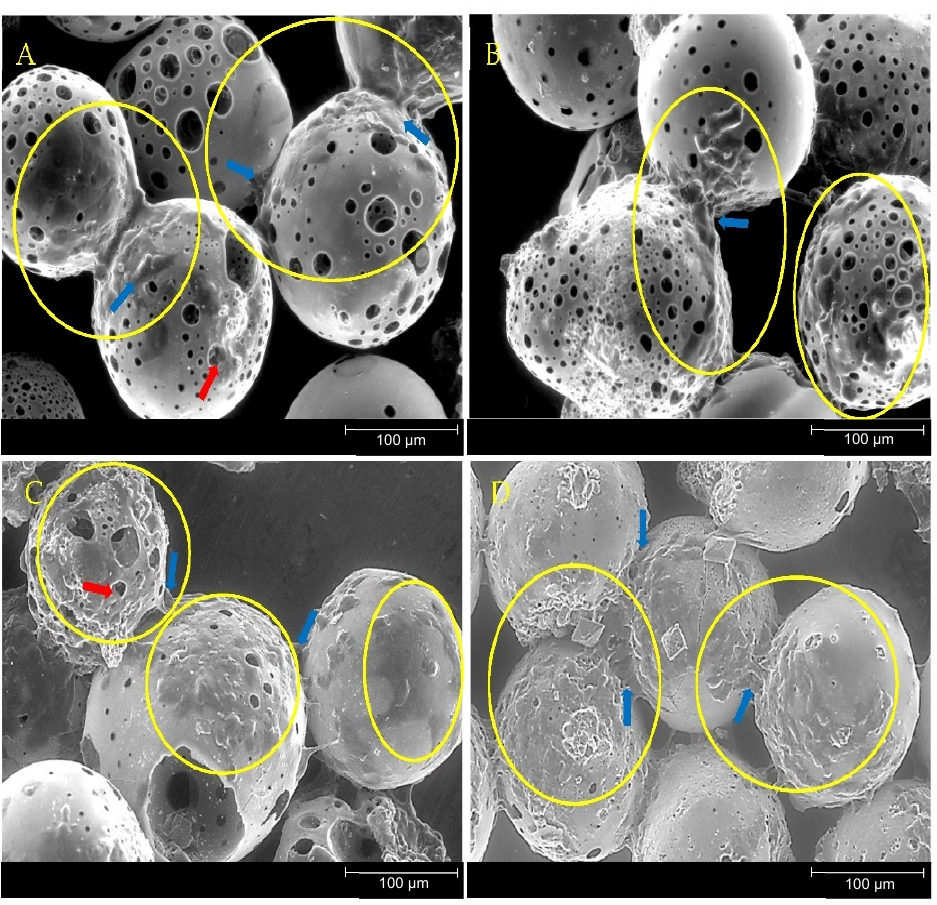
Figure 10. ESEM images of ( A ) P40, ( B ) P35, ( C ) P32.5 and ( D ) P30 PMS after 7 days of direct culture with MG63 cells. Yellow circles indicate regions of cells attachment and the formation of colonies on the microspheres’ surface. Blue arrows indicate cell projections bridging between adjacent microspheres and red arrows to indicate where the cells were penetrating into the pore regions.